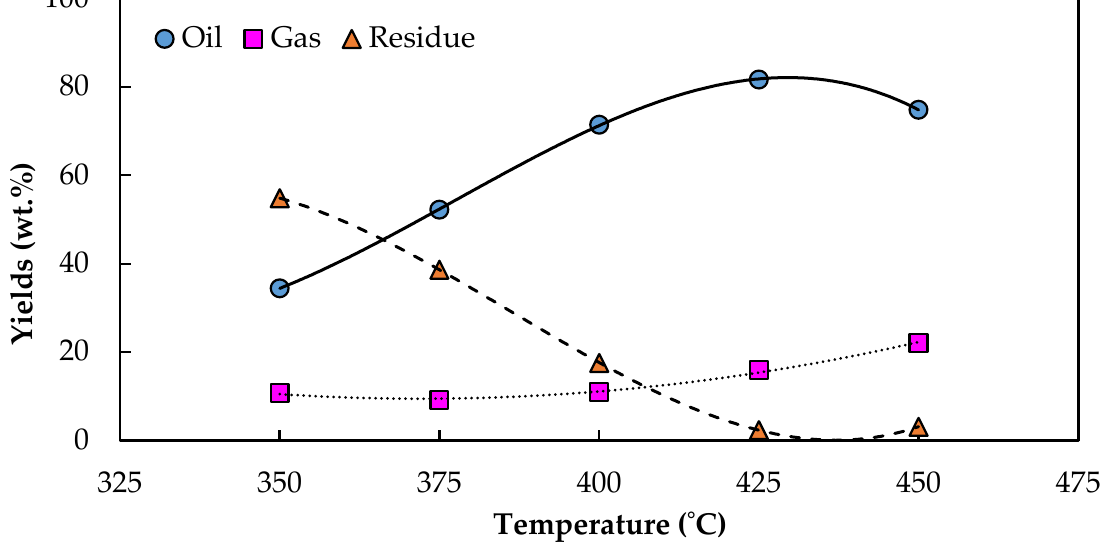
Figure 4. The influence of temperature on the product yields of pyrolysis reactions. (Operating conditions: a flow rate of N 2 of 40 mL/L without a catalyst and a pyrolyzed temperature range of 350–450 °C.)